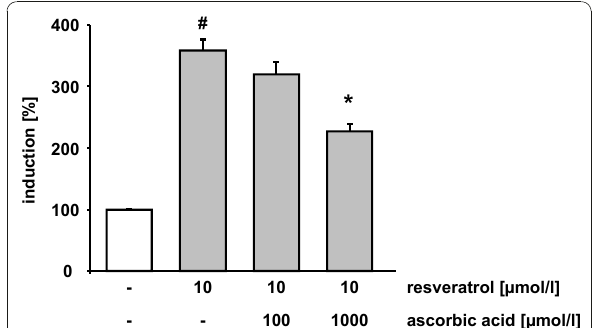
Figure 4 Effects of resveratrol and ascorbic acid on Nrf2 transactivation . HUH7 cells were supplemented with resveratrol in the absence and presence of 100 and 1000 μ mol/l ascorbic acid. Data are mean ± SEM of at least 3 experiments performed in triplicate. # indicates significant difference between control and 10 μ mol/l resveratrol p < 0.05, Mann-Whitney-U-Test; * indicates significant differences compared to 10 μ mol/l resveratrol p < 0.05,